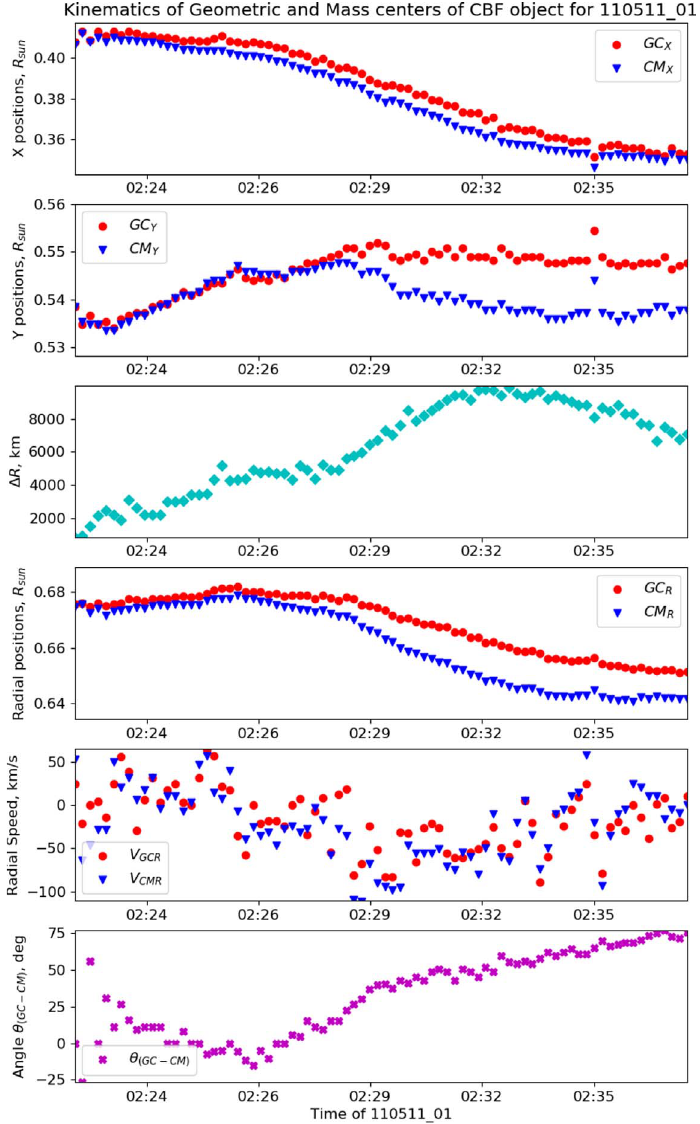
Fig. 14. Kinematics of the center of mass and geometric centers for the event on May 11, 2011. The rows show GC and CM X -, Y -, and R -positions, the magnitude of the distance between the GC and CM in km, and the angle between the two points as a function of